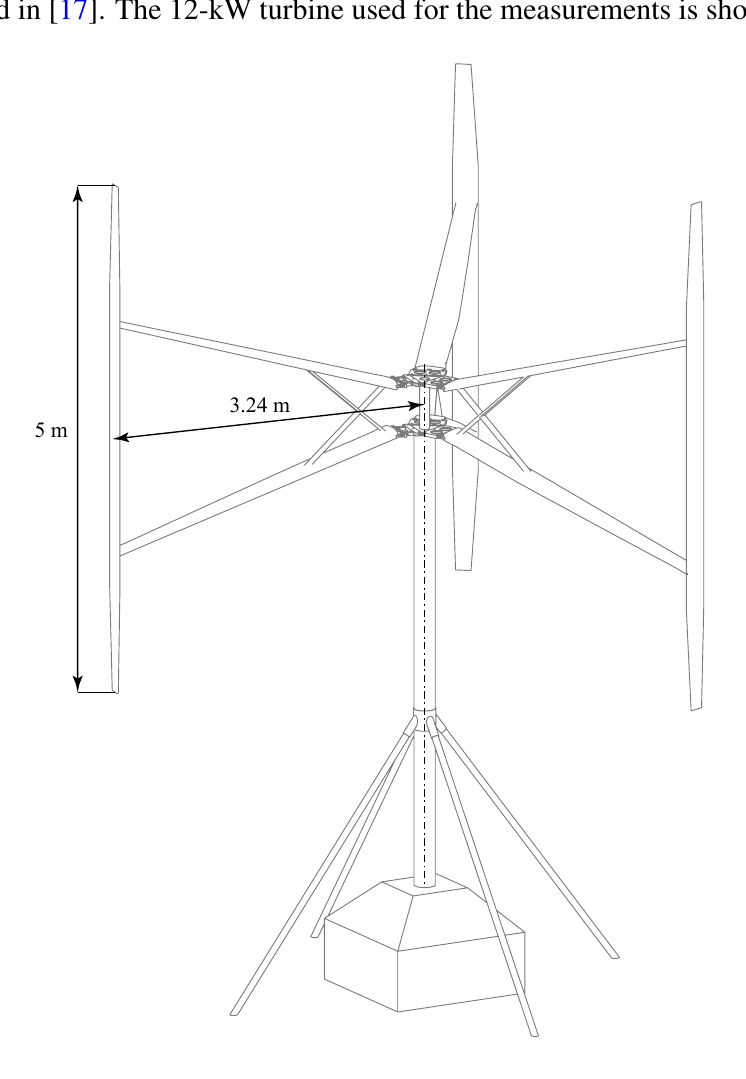
Figure 2. The VAWT with installed load